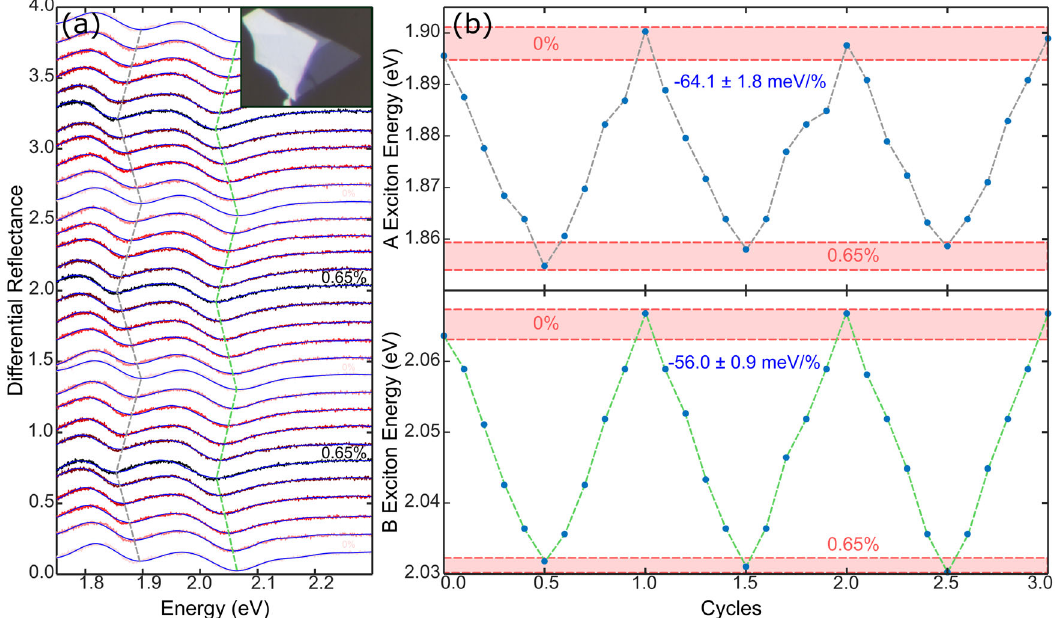
Fig. 5 Reproducibility of straining experiments. a Differential re fl ectance spectra acquired at different uniaxial strain values, up to 0.65%, to probe its reproducibility. b A and B exciton energies for the different strain cycles between 0 and 0.65%.